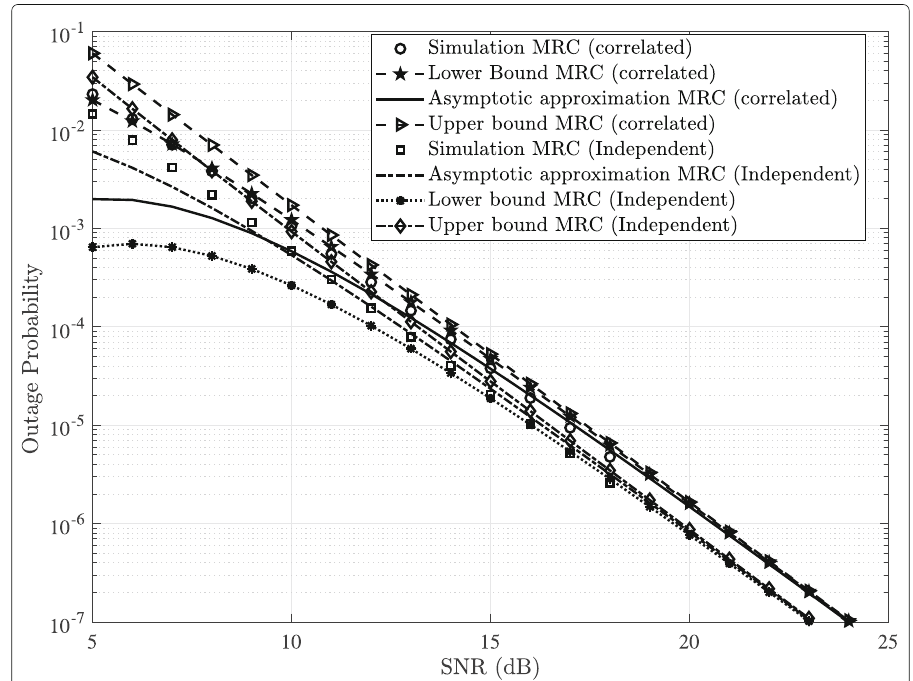
Fig. 2 OP curves for the asymptotic approximation, lower bound, and upper bound for MRC over correlated and independent BX fading channels. The number of branches is N = 2, the fading parameter is m = 1.5, and (cid:12) C 1 , 0 2 × 2 , 0 2 × 2 ; 0 2 × 2 , C 2 , 0 2 × 2 ; 0 2 × 2 , 0 2 × 2 , C 3 the correlation structure is C b = C 1 = C 2 = C 3